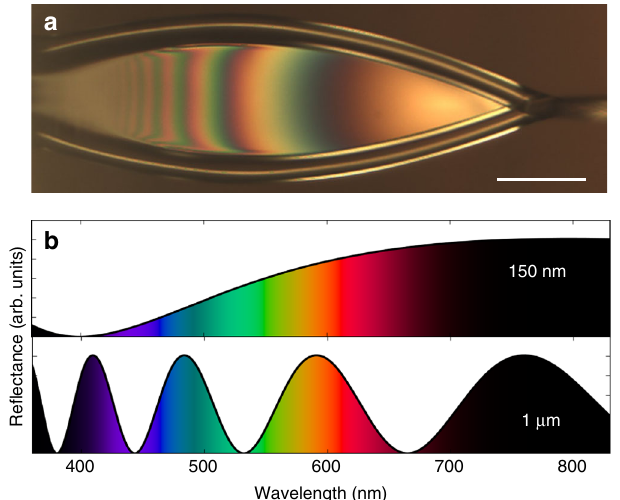
Fig. 3 Spectral re fl ectance of water. An optical re fl ection image of an ultrathin liquid sheet is shown in a , highlighting the thin- fi lm interference fringes. The calculated spectral re fl ectance of water for fi lms of 150 nm and 1 μ m thickness are shown in b . The scale bar in a is 50 μ m